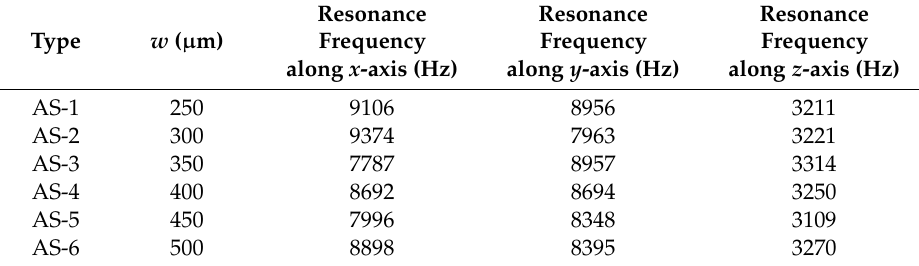
Figure 7. The characteristic curves of resonance frequency when w is 500 µ m: ( a ) along the x -axis; ( b ) along the y -axis; and ( c ) along the z -axis. Table 2. The resonance frequencies of the proposed sensor with different intermediate double beam widths.